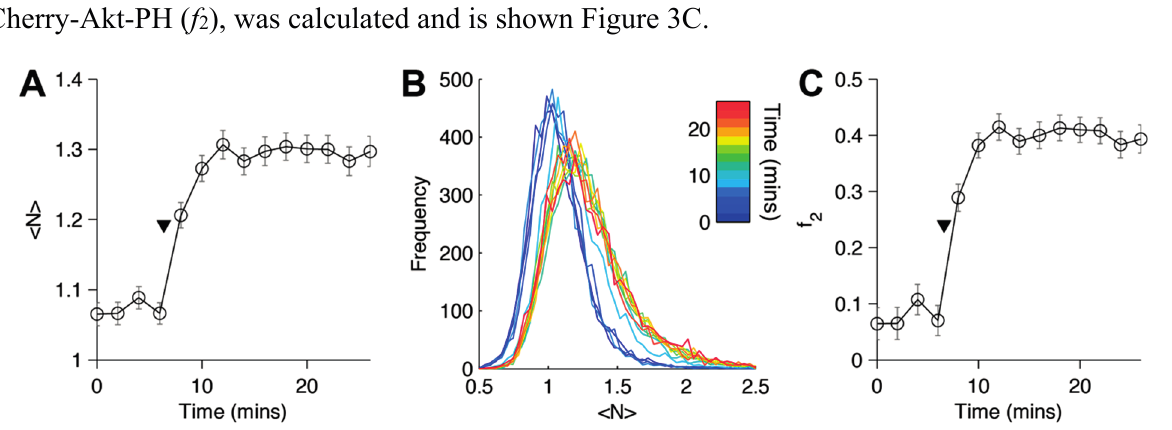
Figure 3. Average values of calculated cluster parameters for a time course of a cell transfected with mCherry-Akt-PH and stimulated with platelet-derived growth factor (PDGF). Cluster parameters for the mCherry-Akt-PH transfected cells shown in Figure 2 as a function of time. ( A ) Average cluster size N ; ( B ) histogram of average cluster size N at each timepoint and ( C ) average fraction of dimers to monomers, f 2 . Error bars represent 95% confidence